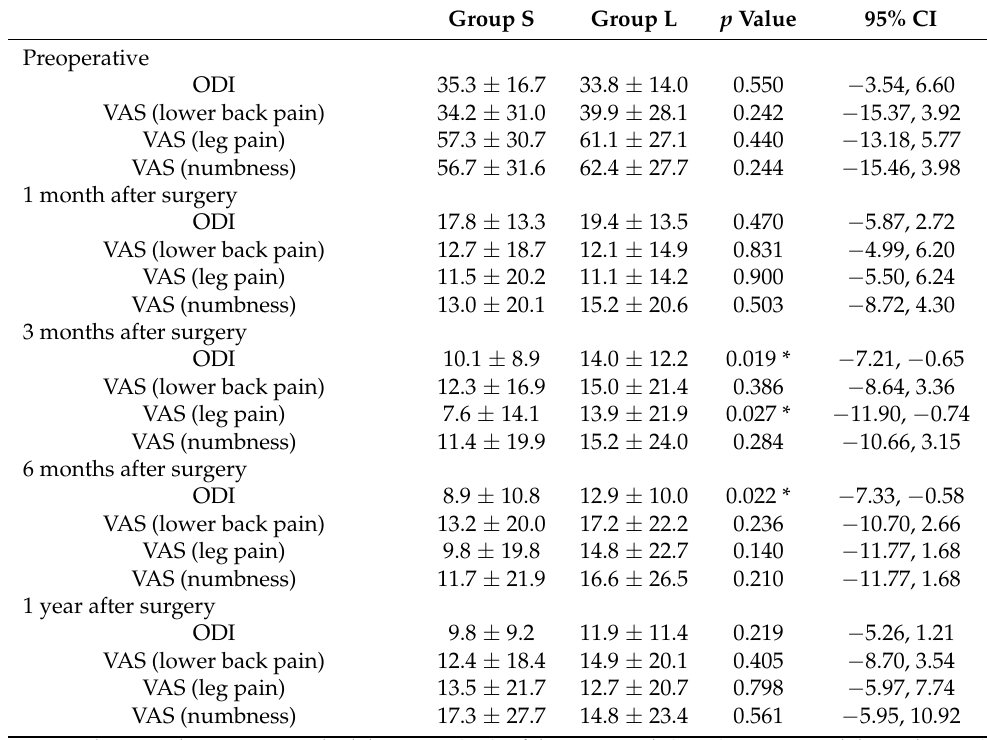
Data are shown as the mean ± standard deviation; CI, Confidence Interval; ODI, Oswestry Disability Index; VAS, Visual Analog Scale *, p < 0.05; In group S, the duration of symptoms (DOS) was <12 months; in group L, the DOS was ≥ 12